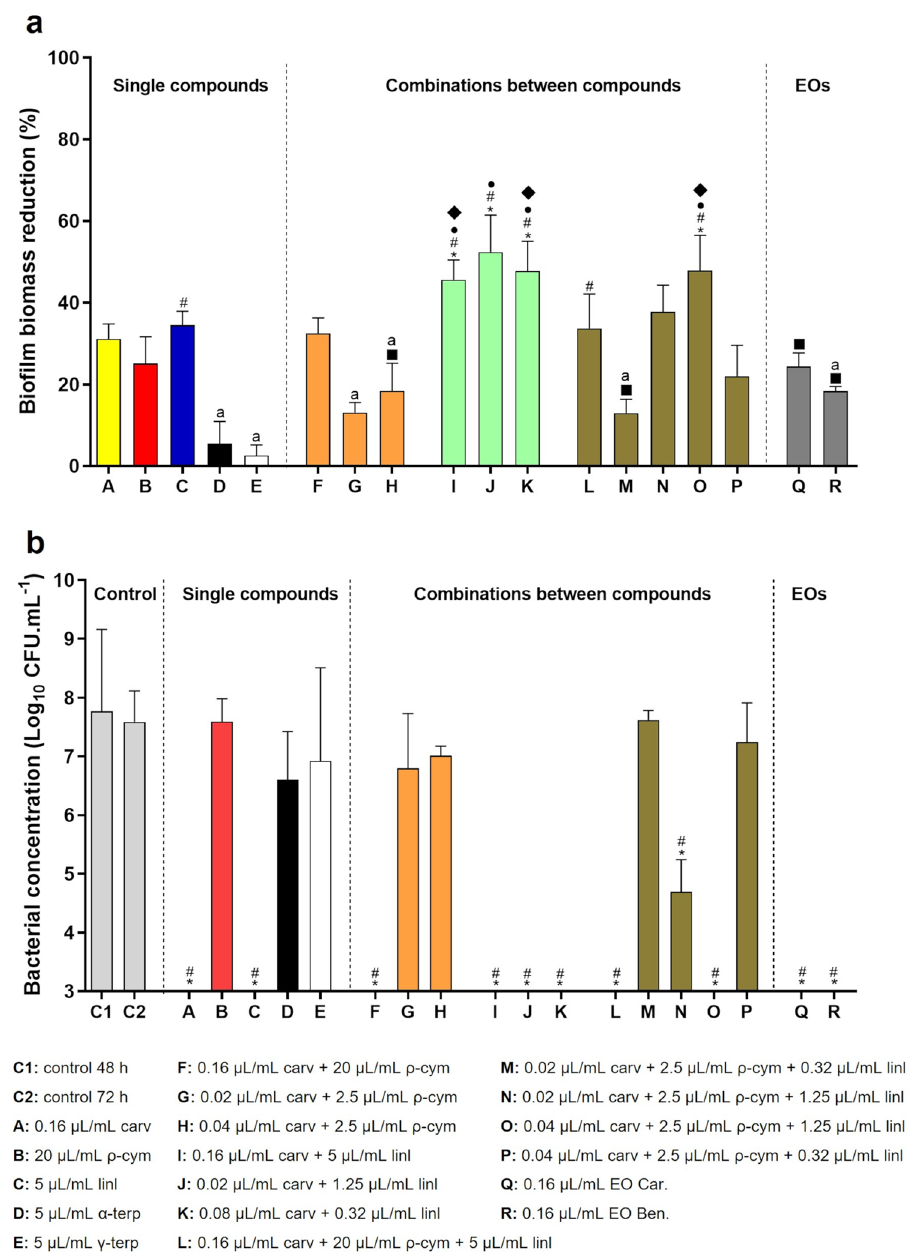
Figure 2. Activity of single components, combinations between compounds and EOs from Thymbra capitata on a 48 h Gardnerella sp. UM241 biofilm. ( a ) Effect on biofilm biomass reduction. Results are presented in mean percentage (%) of biofilm biomass reduction. ( b ) Effect on biofilm cells culturability. Results are represented as mean of Log (CFU.mL −1 ) with a limit of detection of Log=3. Primary colors were selected to represent the individual components and the mixtures represent the color combination of the individual components. Statistical analysis was performed using one-way ANOVA (n ≥ 3). In panel ( a ), differences are showed, when p < 0.05, by asterisk symbol when comparing with 5 µL/mL α-terp; hash symbol when comparing with 5 µL/ mL γ-terp; bullet symbol when comparing with 0.02 µL/mL carv + 2.5 µL/mL ρ-cym; filled square symbol when comparing with 0.02 µL/mL carv + 1.25 µL/mL linl and filled diamond symbol when comparing with 0.02 µL/ mL carv + 2.5 µL/mL ρ-cym + 0.32 µL/mL linl. All conditions are statistically different from the 48 h-biofilm control except for the cases marked ( a ). In panel ( b ), differences are represented by asterisk symbol when comparing with control 48 h and hash symbol when comparing with control 72 h, when p <